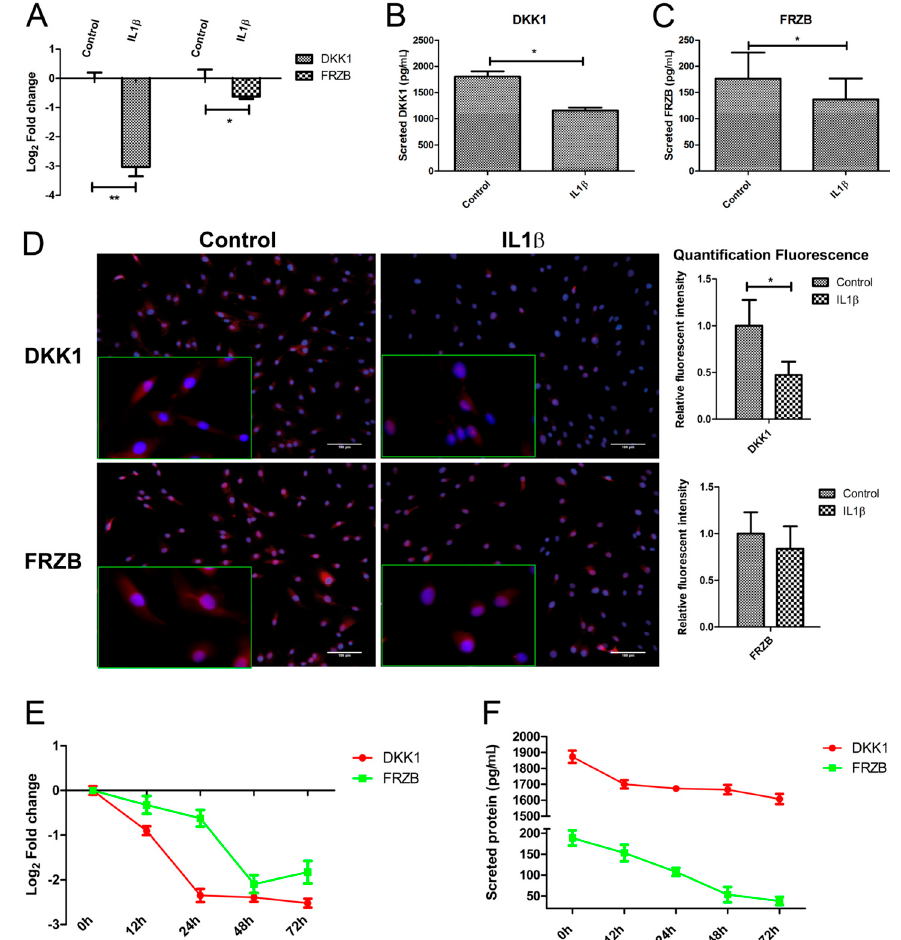
Figure 3. IL1 β decreased expression of Dickkopf-1 (DKK1) and Frizzled related protein (FRZB) at mRNA and at the protein level. Human primary chondrocytes were treated with IL1 β for 24 h. ( A ); ( B , C ). DKK1 and FRZB gene and protein expression were measured by qPCR and Enzyme-Linked Immunosorbent Assay (ELISA), respectively; ( D ) The expression of DKK1 and FRZB was measured by IF. DKK1 and FRZB are illustrated in red and nuclei are in blue (scale bar 100 µ m), magnified pictures were indicated in inserts. Quantification of immunofluorescence intensity was performed using CellProfiler software; ( E , F ). IL1 β decreased DKK1 and FRZB expression is time-dependent. Time-course evaluation of DKK1 and FRZB expression after IL1 β stimulation. * p < 0.05, ** p < 0.01: significant correlation.